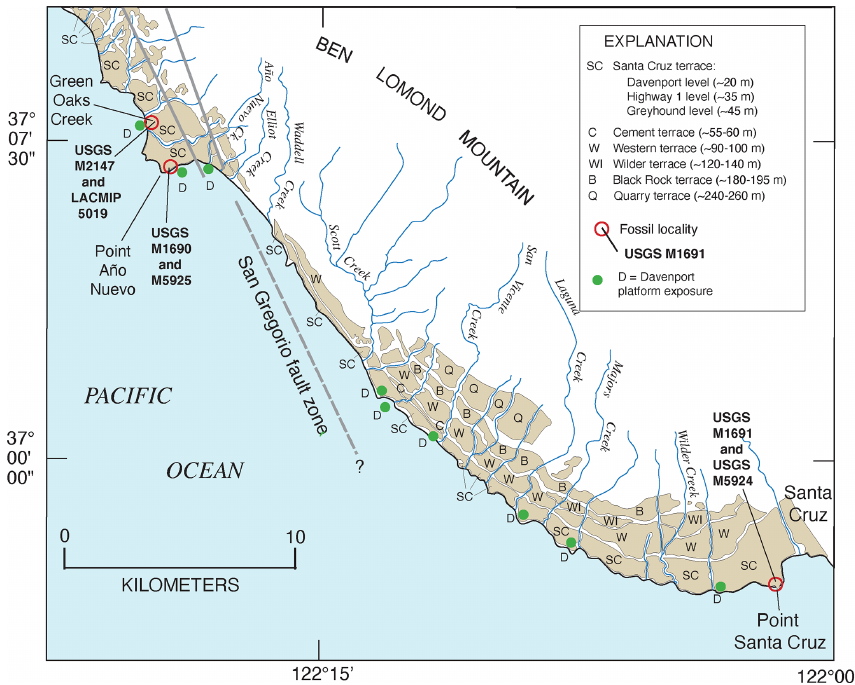
Figure 24. Map of a portion of the central coast of California, from Santa Cruz to just north of Point Año Nuevo, showing marine terraces, fossil localities, and location of the San Gregorio fault zone (solid gray lines; dashed where uncertain). Marine terrace inner edges redrawn from Bradley and Griggs (1976) and Weber et al. (1979); location of the San Gregorio fault zone from Weber et al. (1979) and Weber (1990).